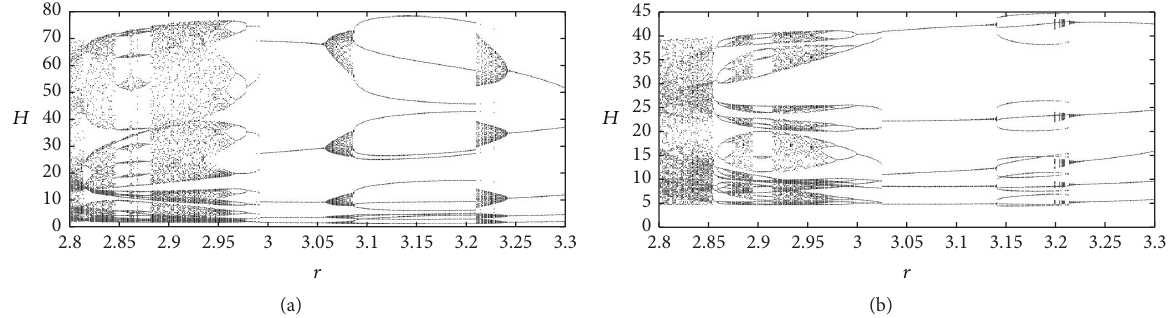
Figure 4: Bifurcation diagrams with respect to the intrinsic growth rate 𝑟 with different 𝑞 values. The parameter values are as follows: 𝑇 = = 0.5 , 𝐾 = 50 , 𝛿 = 0.3 , 𝛾 = 1 , 𝛼 = 0.01 , 𝜃 = 0 , 𝑞 = 0 in (a), and 𝑞 = 0.05 in 10 , 𝑇 ℎ